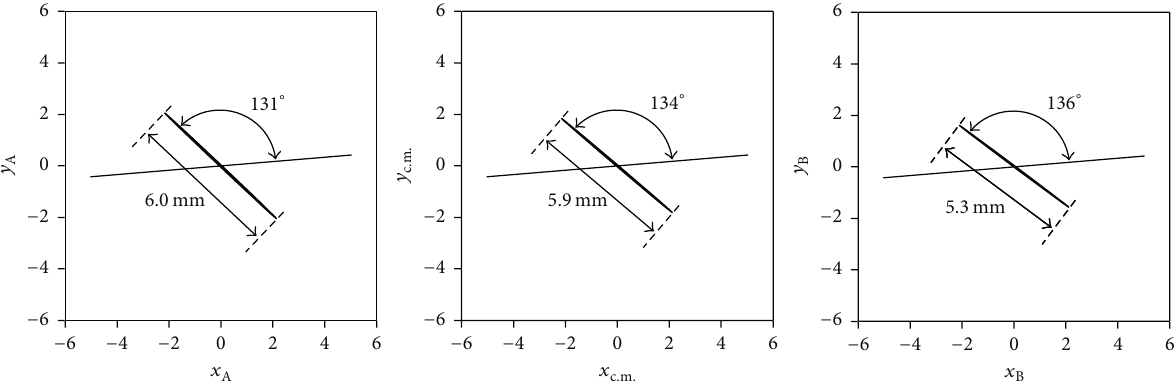
Figure 8: Movement in front supporting position (A), center of mass (c.m.), and rear supporting position (B) for nominal operating conditions, full